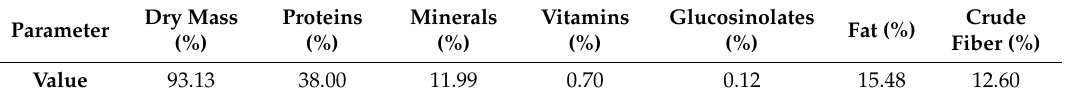
Figure 1. Rapeseed cake: ( a ) pellet, ( b ) milled pellet. Table 1. The average chemical composition of rapeseed cake (per 1 kg of rapeseed cake).